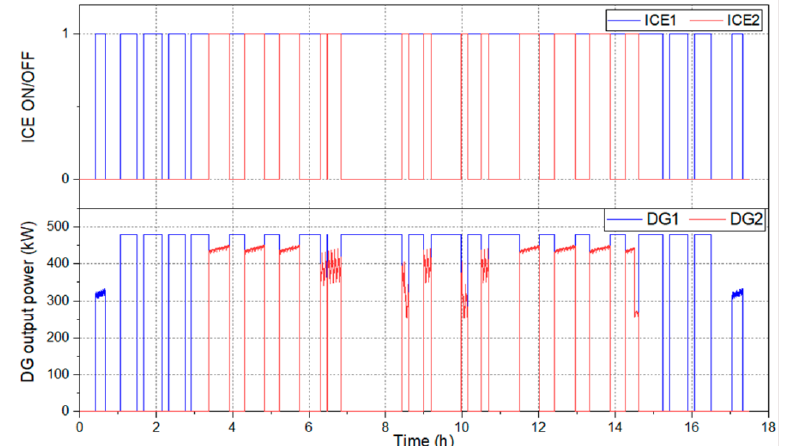
Figure 16. DGs working performance in HIL